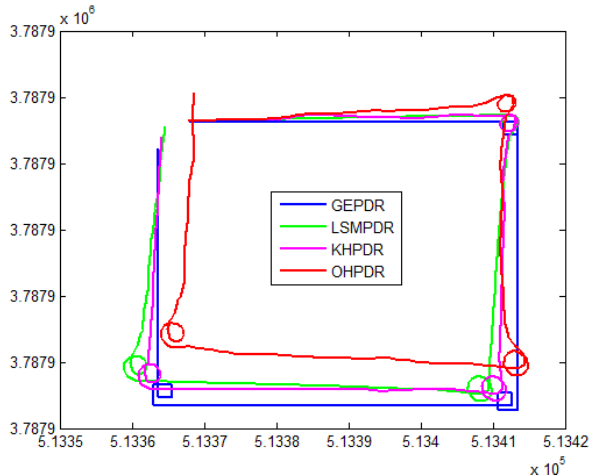
Figure 14. Positioning trajectory analysis for different solutions associated with PDR .